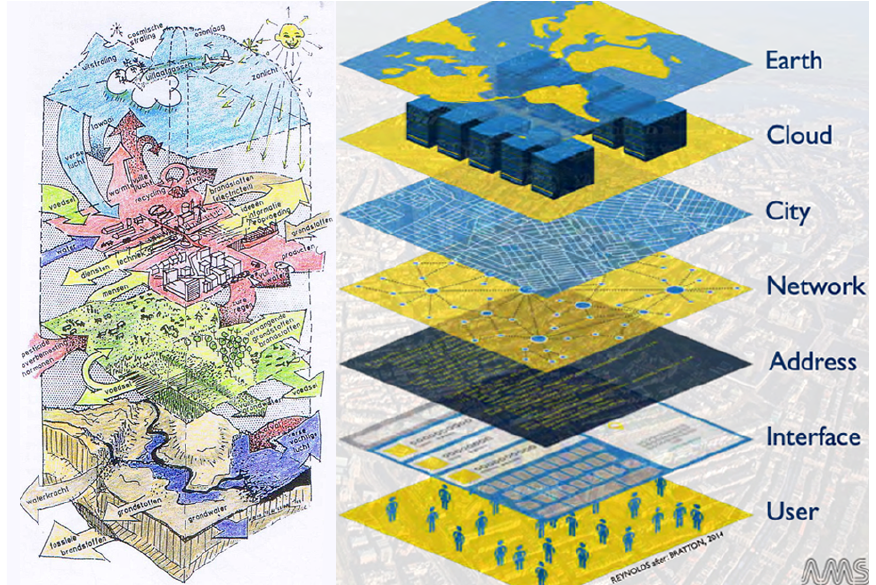
Figure 2. Kristinsson’s (2012) 3D-model of the city as an ecosystem (left); van Timmeren and Henriquez’ (2015) “the Stack” layers including recent digital additions